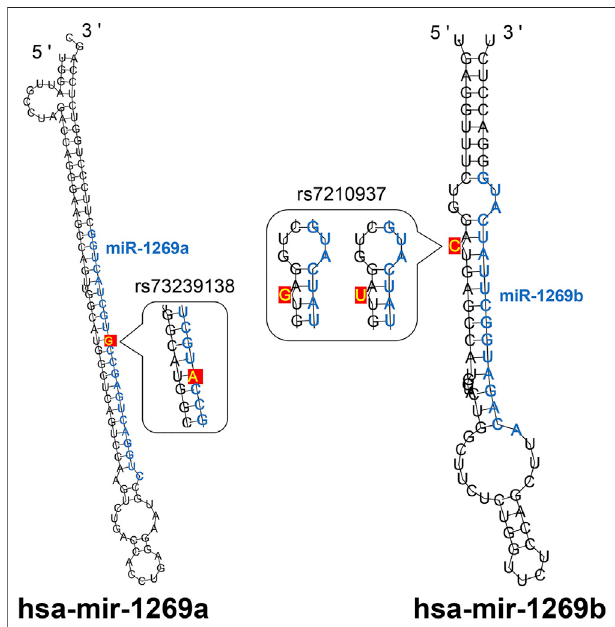
FIGURE 3 | The stem-loop structures of hsa-mir-1269a and hsa-mir- 1269b. The schematic diagram mainly shows the obvious differences in the stem-loop structure of hsa-mir-1269a and hsa-mir-1269b. The blue letters in the fi gure are the sequences of mir-1269a and mir-1269b. It is